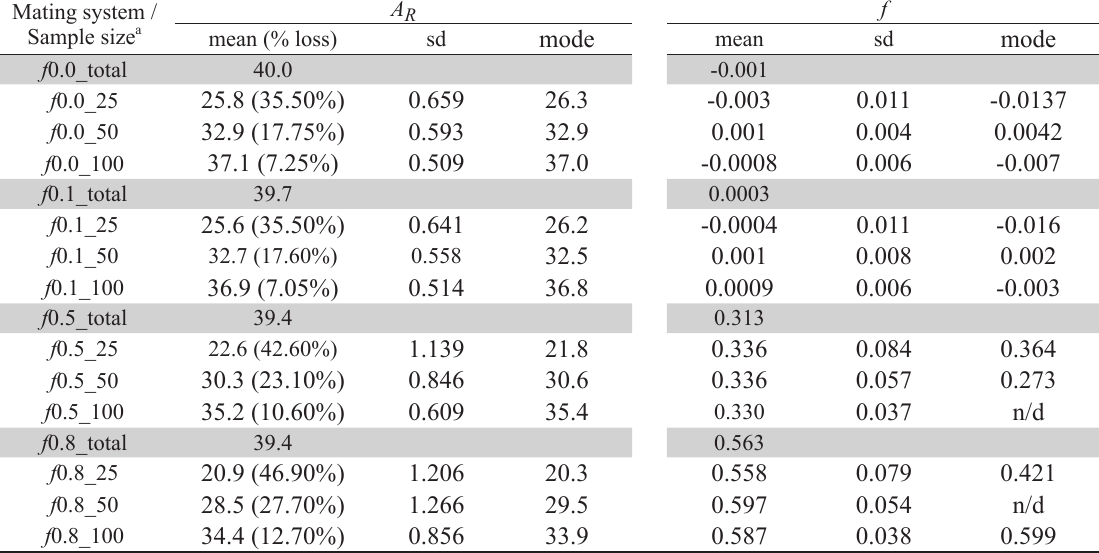
Estimations of allelic richness ( A ) and inbreeding coefficient ( f ) for R sub-sets of the total population. Means, standard deviation and mode are presented for each parameter. Percentage of loss of allelic richness in relation to the total populations is